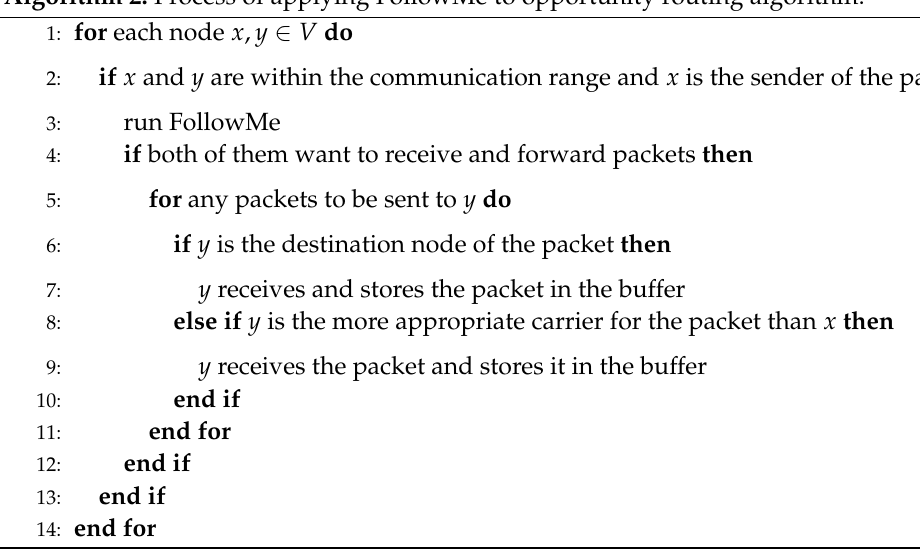
Algorithm 2: Process of applying FollowMe to opportunity routing